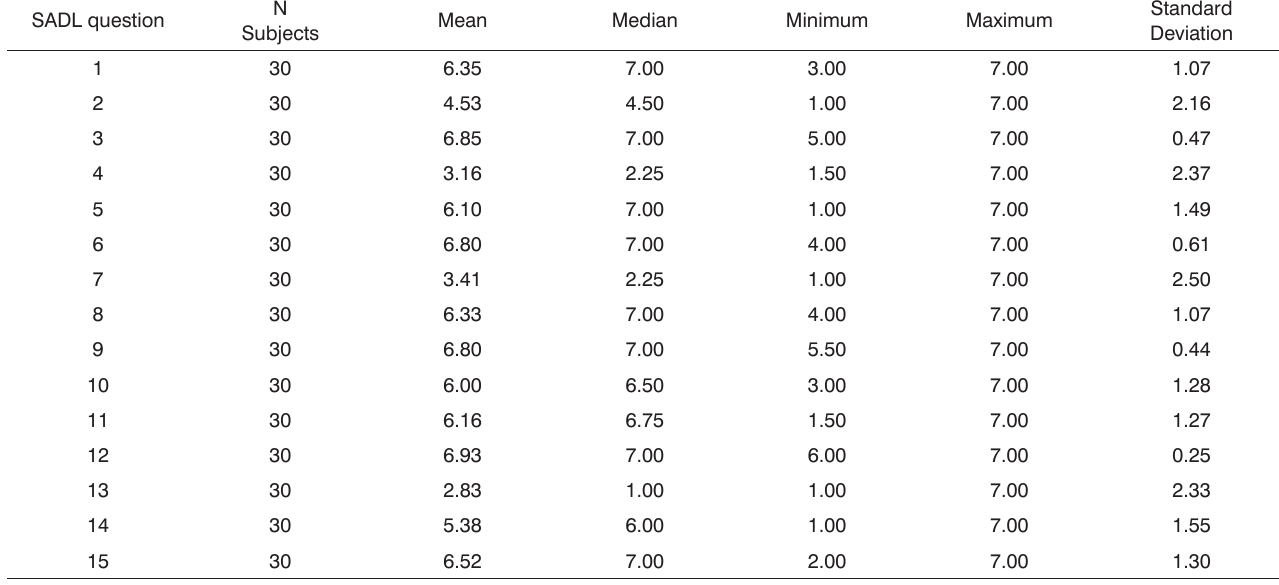
Table 1. Distribution of the mean value results between the first and the second application of each question in the SADL ques- tionnaire as to the mean, media, minimum value, maximum value and standard deviation.